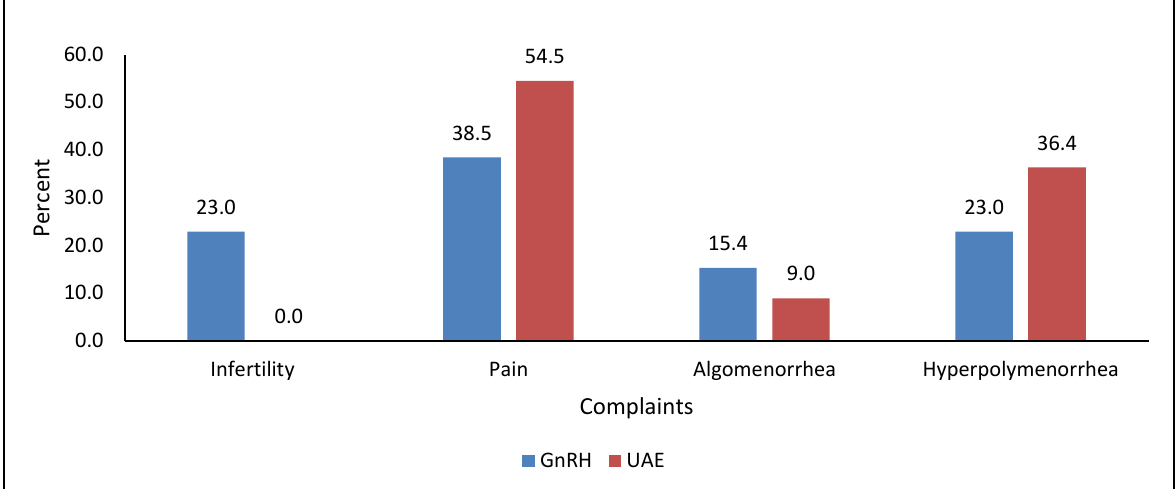
Figure 1. Breakdown of patients’ complaints stratified by intervention